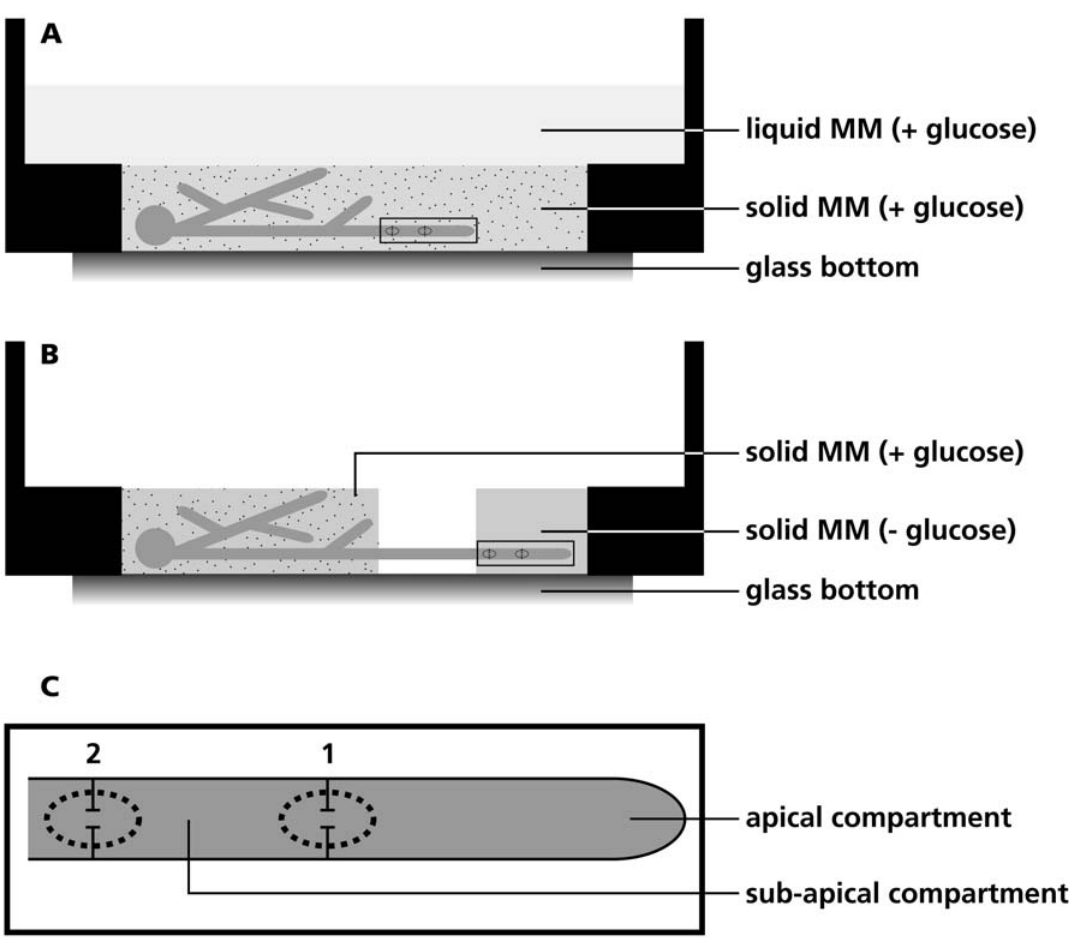
Figure 1. Glass bottom culture dish used to assess plugging of septa in S.commune . In most cases S.commune was grown in a thin layer of agar medium overlaid with minimal medium (A). However, liquid medium was not added when it was assessed whether septa were open or closed in the absence of glucose in the medium. In this case, the culture dish contained distinct patches of minimal medium with or without glucose, which were separated by a gap of 5 mm (B). (C) Magnification of boxed area in (A) and (B) showing a hypha with the first and second septum as referred to in the text.